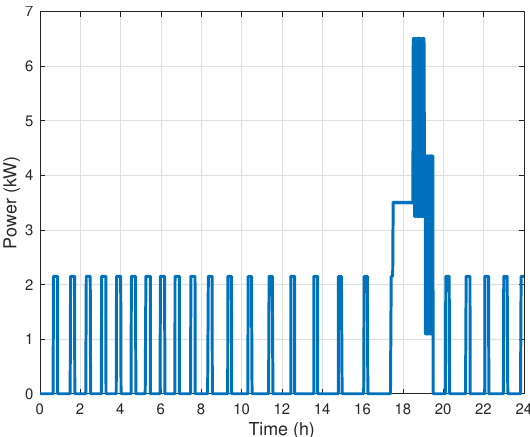
Figure A6. Laundry shelter equipment power.